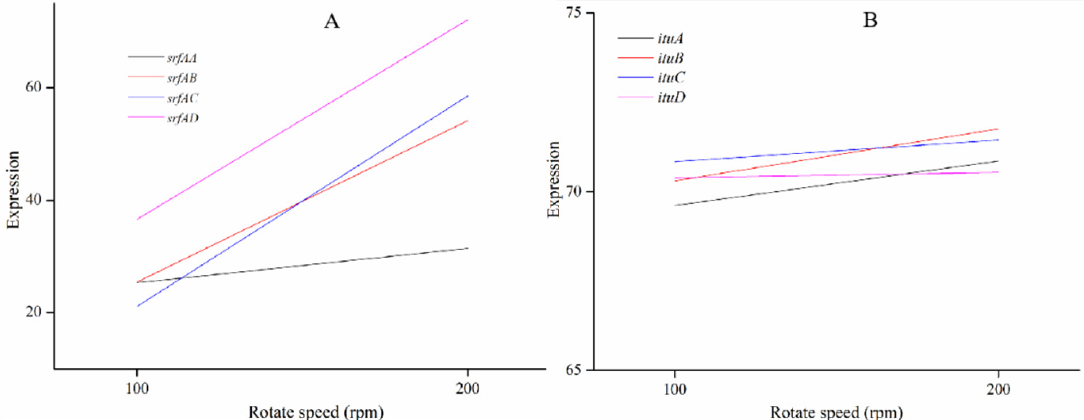
Figure 5. The expression of lipopeptides, surfactin ( A ) and iturin ( B ) biosynthesis genes in Bacillus velezensis CMT-6.